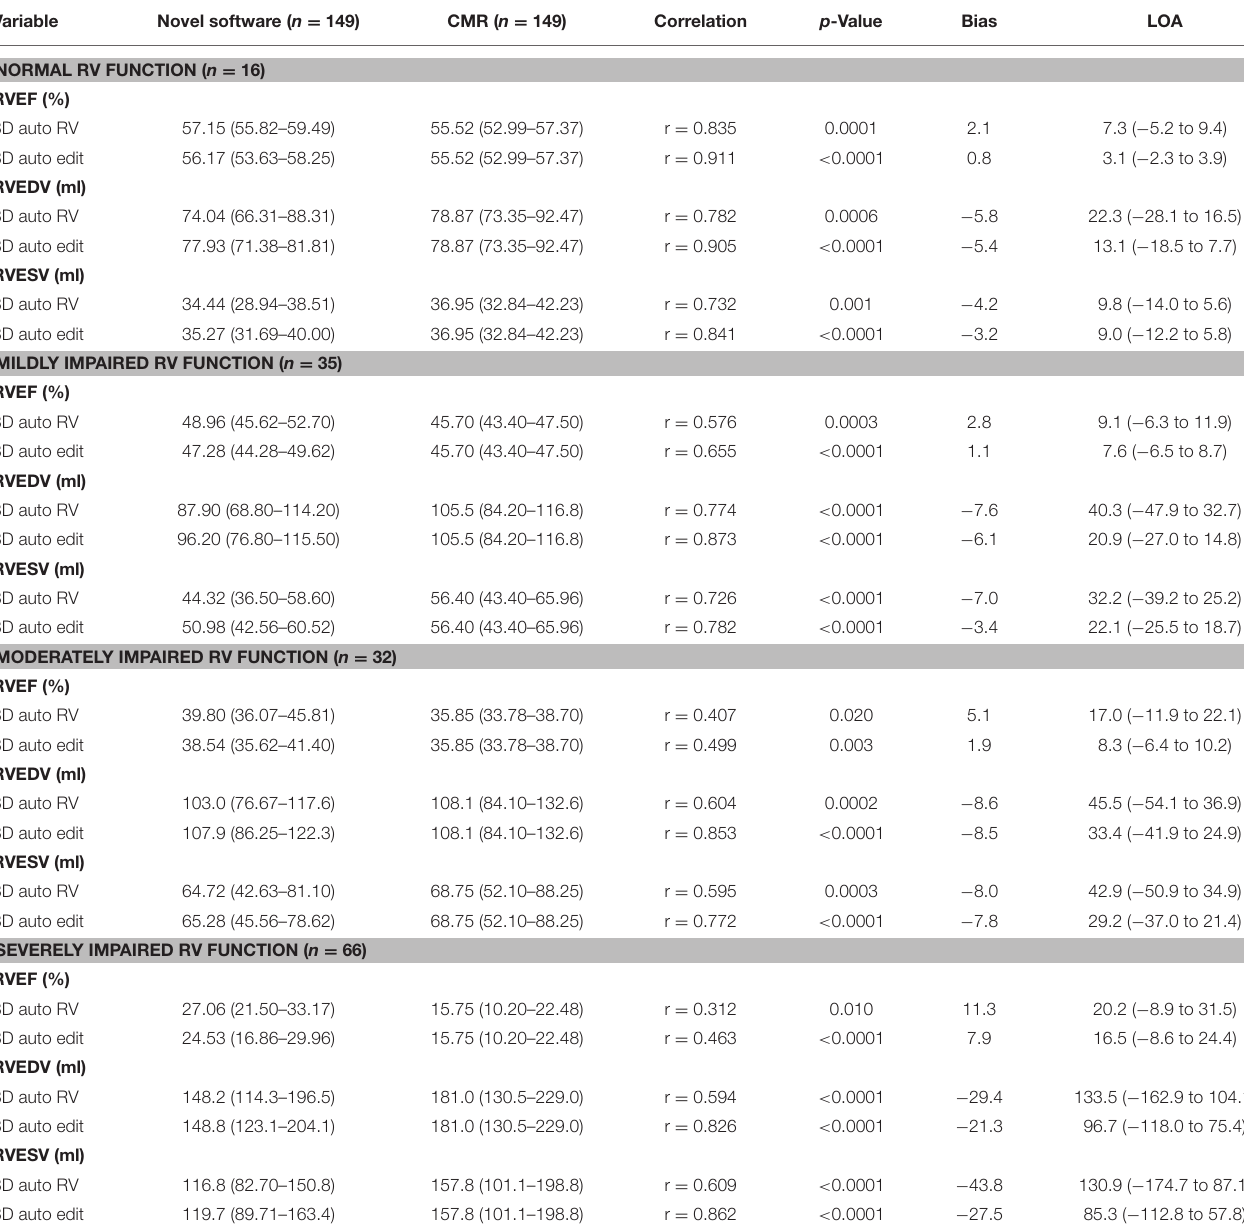
TABLE 3 | The effect of right ventricular ejection fraction (RVEF) on 3D-Auto RV quantification with or without manual editing compared with CMR.